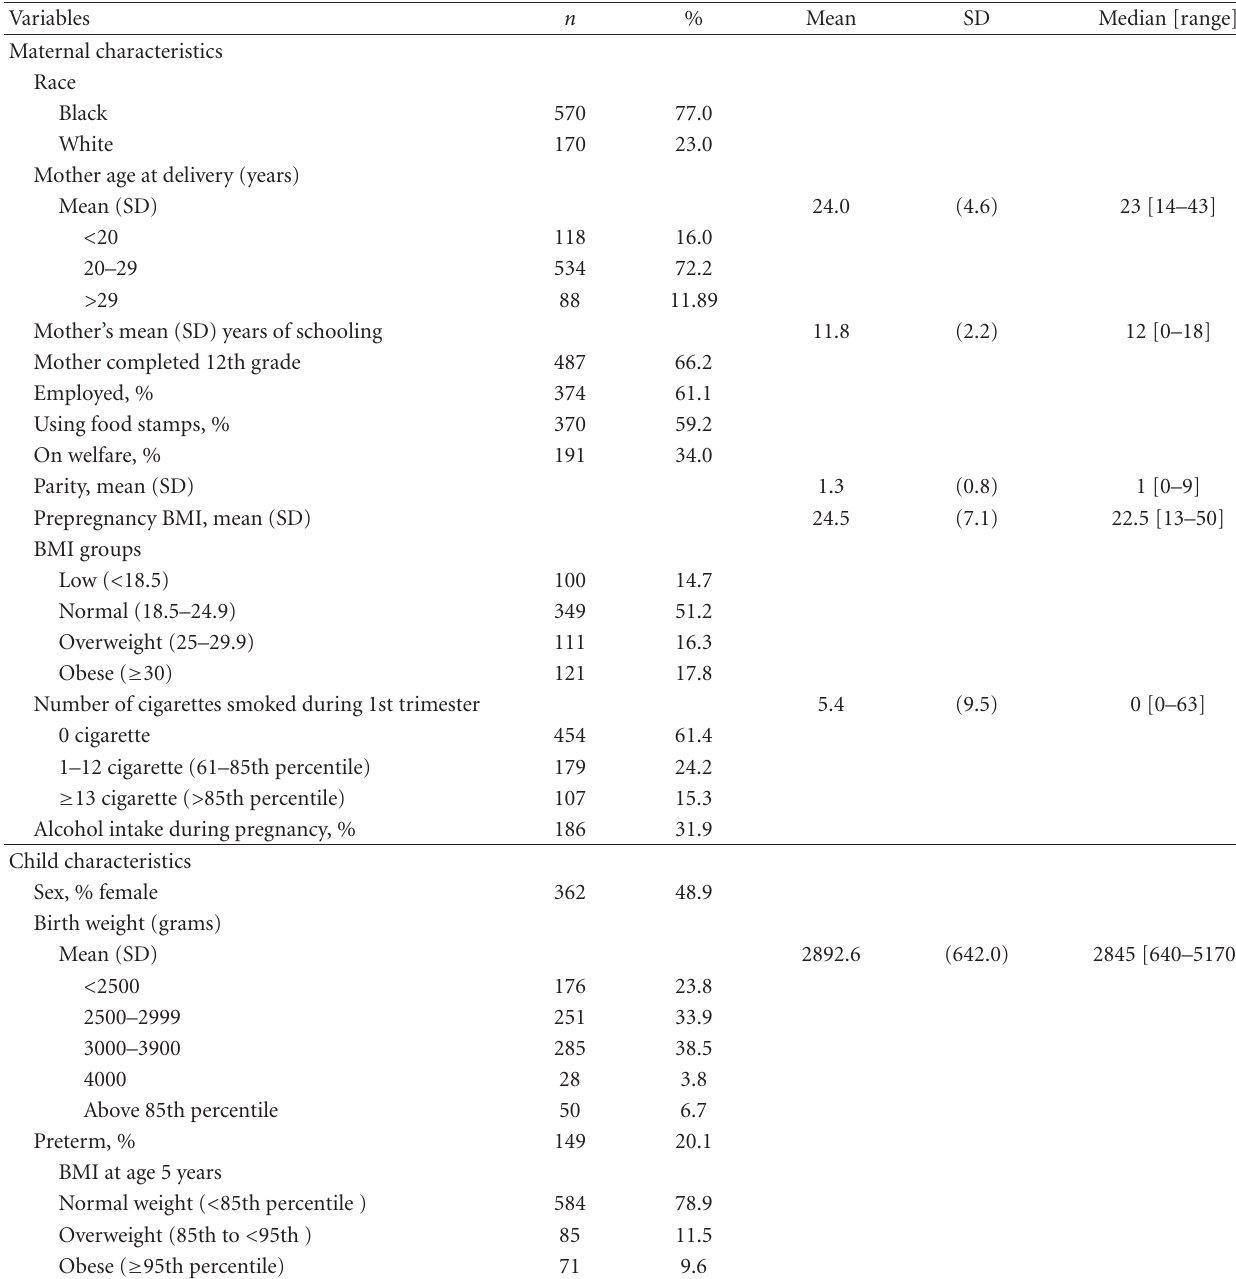
Table 1: Characteristics of the participants and early childhood determinants of obesity at the age of 5 in Alabama ( n =